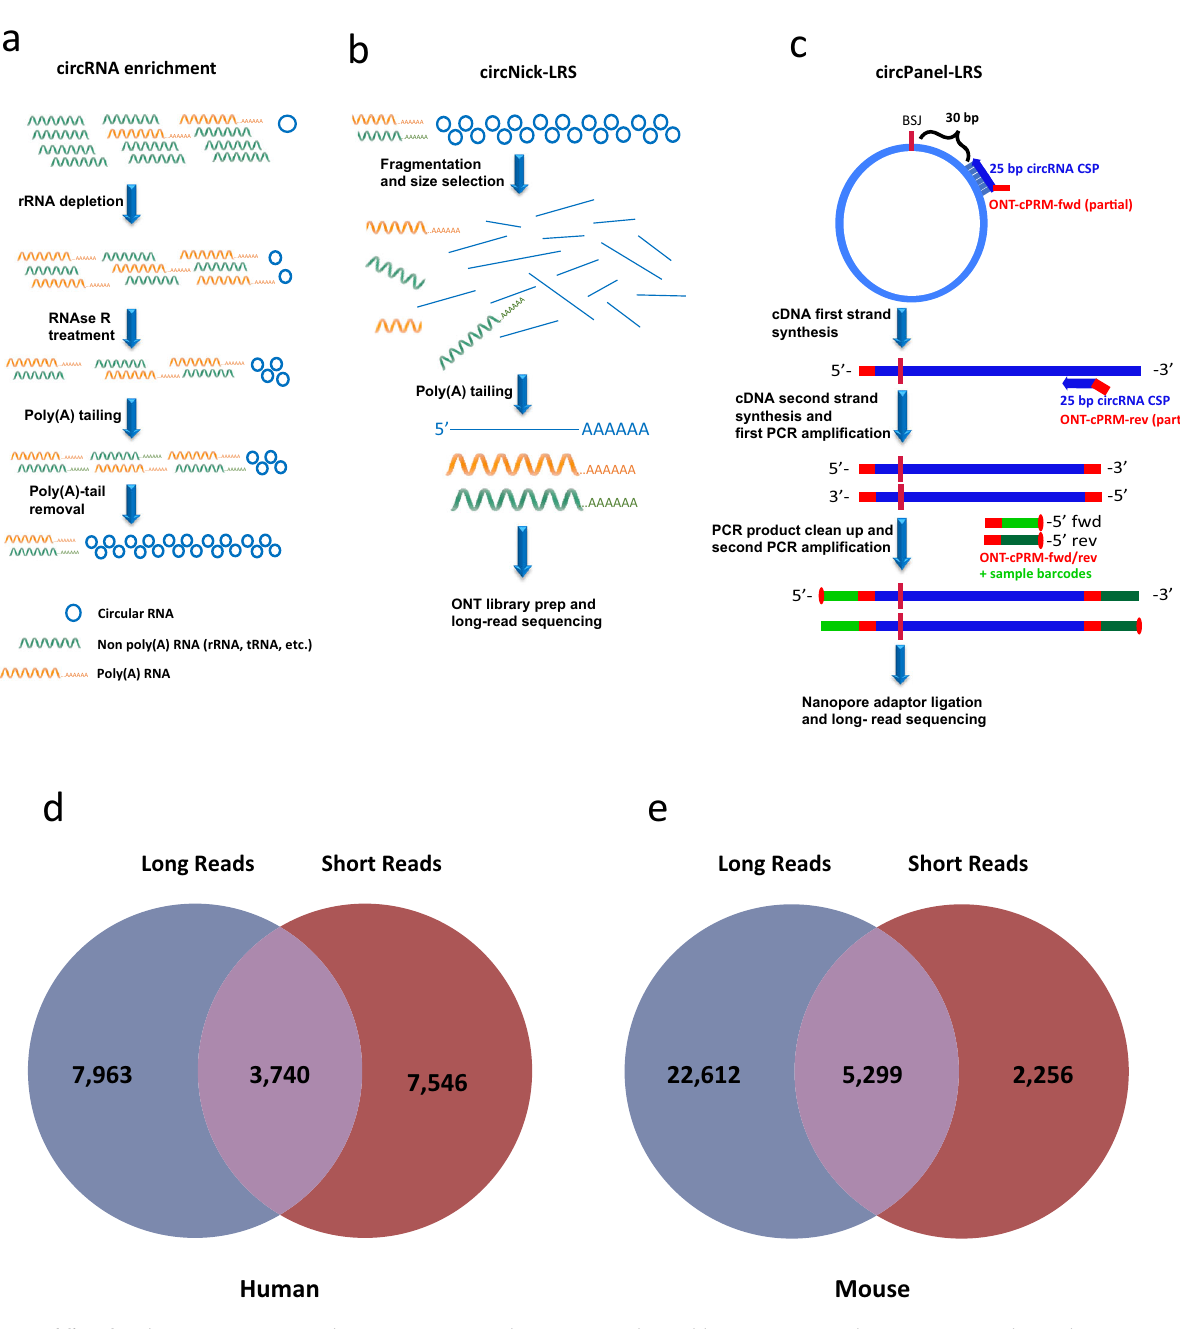
Fig. 1 Work fl ow for circRNA ONT sequencing. a CircRNA enrichment protocol. Total human or mouse brain RNA was subjected to DNase treatment and rRNA depletion before treatment with RNase R to digest the linear RNAs. To further enrich for circRNAs, the remaining linear RNAs were polyadenylated and depleted using poly(A) puri fi cation beads. b CircRNA library preparation. The enriched circRNA pool was nicked using an optimized protocol to generate large fragments. After phosphorylation of the 5 ′ ends of the linearized RNAs, the obtained RNA pool was subjected to polyadenylation to align with the ONT sequencing protocol. c CircRNA panel Long-Read Sequencing (circPanel-LRS). Total RNA was reverse transcribed using a panel of circRNA-speci fi c primers (CSP) extended with an oligo sequence partially overlapping the ONT-cPRM (ONT cDNA primer) forward primer oligo. The second strand of the cDNA was synthesized using a panel of reverse circRNA-speci fi c paired primers extended with an oligo sequence partially overlapping the ONT-cPRM reverse primer oligo. Six PCR cycles were run using the fi rst and second strand cDNA synthesis primer oligos without prior cleanup for the fi rst PCR ampli fi cation. After cleaning up the PCR product, the resulting library is ampli fi ed using ONT sequencing adjusted and sample indexed primers. Equal molar ratios of the barcoded libraries were mixed and ligated to the ONT sequencing adapter before loading to fl owcells for sequencing. d , e Number of circRNAs detected using long- and short-read sequencing in human and mouse brain